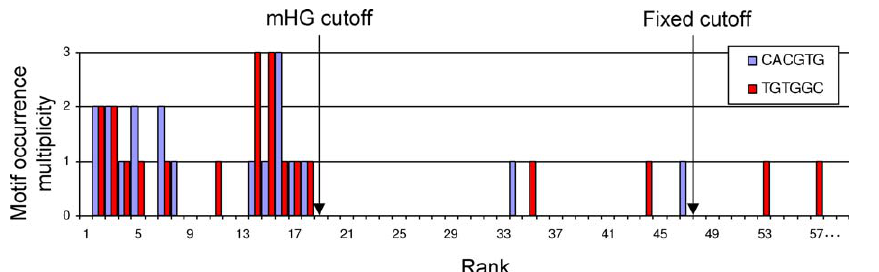
Figure 7. Motif Occurrences in the Top 59 (of ; 6,000) Promoters That Were Ranked According to Met32 Binding Signal A comparison is made between the data-driven mHG cutoff and the arbitrary fixed cutoff. It can be seen that the motifs are significantly more enriched when the list is partitioned using the mHG